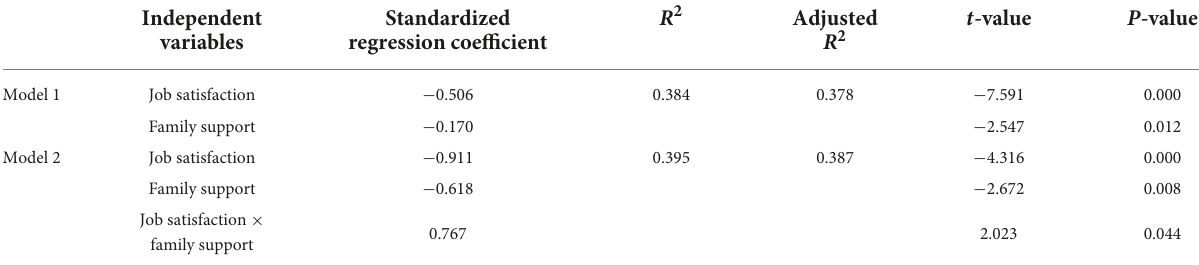
TABLE 7 Moderating effect of family